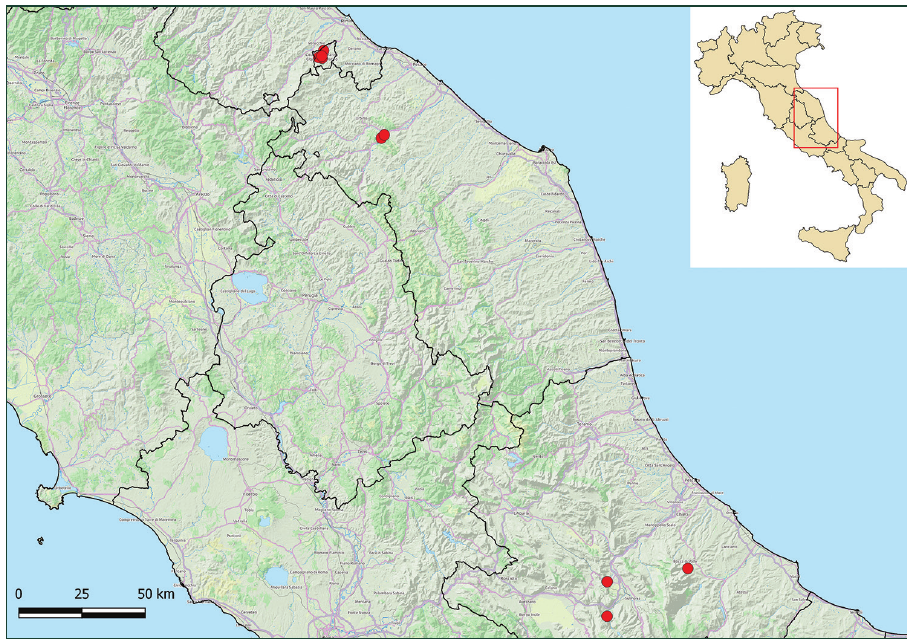
Figure 2. Geographic range and distribution map of Crepis lacera subsp. titani